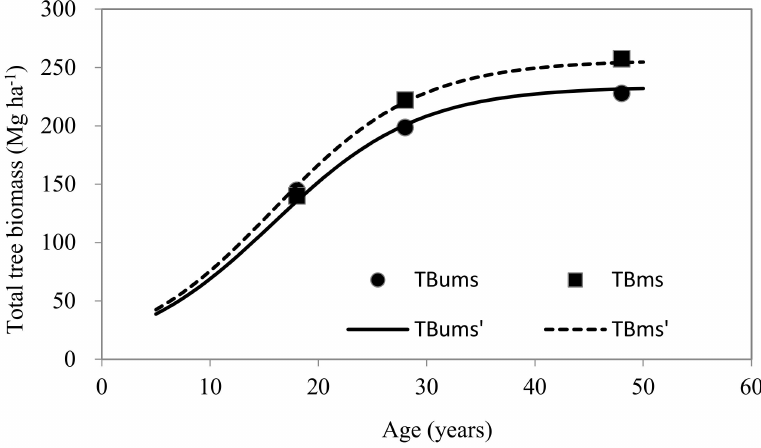
Figure 2. Growth of managed and unmanaged stands of Masson pine ( Pinus massoniana Lamb) in the Taizishan Forestry Administration Bureau, Central